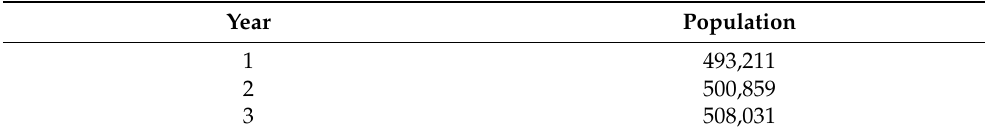
Table 4. Population results for each year of the